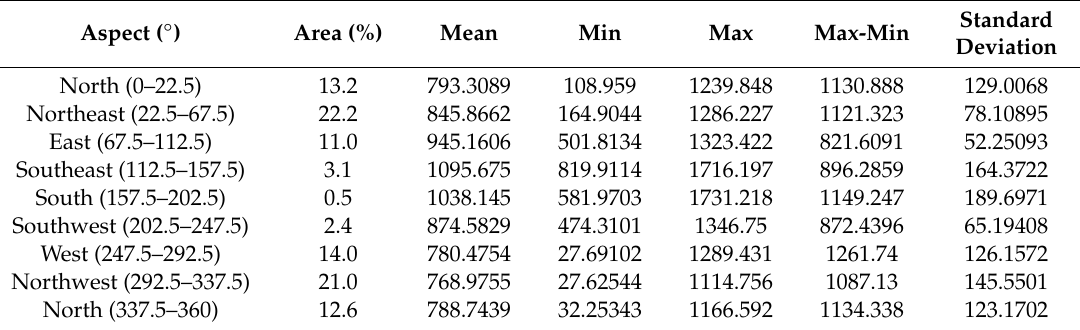
Table 4. Characteristics of the DSSR (W / m 2 ) with the aspect at the S2A / B overpass time on 1